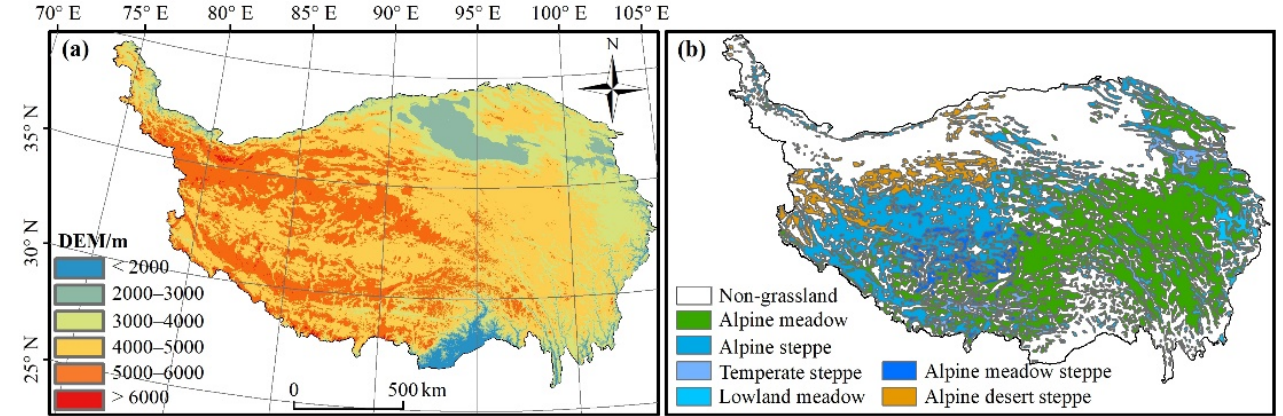
Figure 1. ( a ) Topography of the Qinghai-Tibet Plateau (QTP) and ( b ) the study domain: grassland vegetation zones.